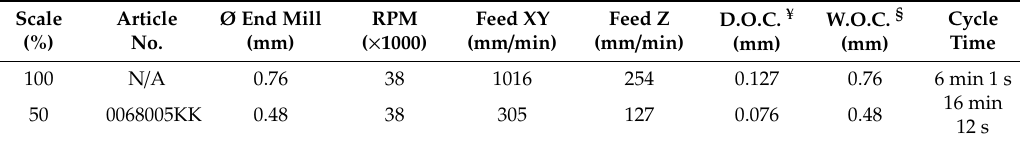
Figure 11. Flexures built with rigid resin – 3D printing (Formlabs). Table 4. Cutting parameters for micromachining with Datron Neo CNC Machine.